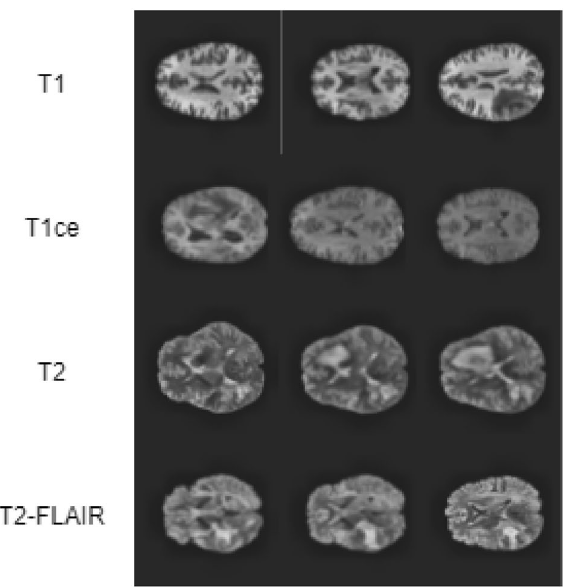
Figure 2. Sample images in BraTS 2020 dataset 16 where each row represents images of the same